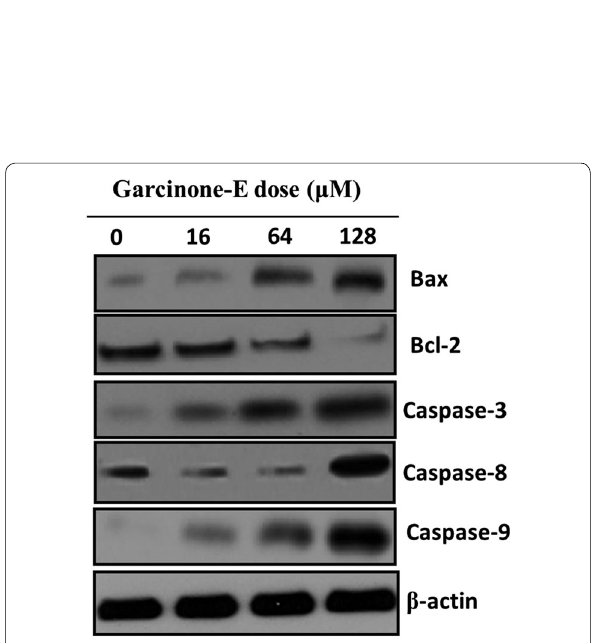
Fig. 6 Western blotting assay indicating the expressions of apoptosis allied proteins and caspase (-3, -8 and -9) proteins. Individual separate experiments were implemented three times